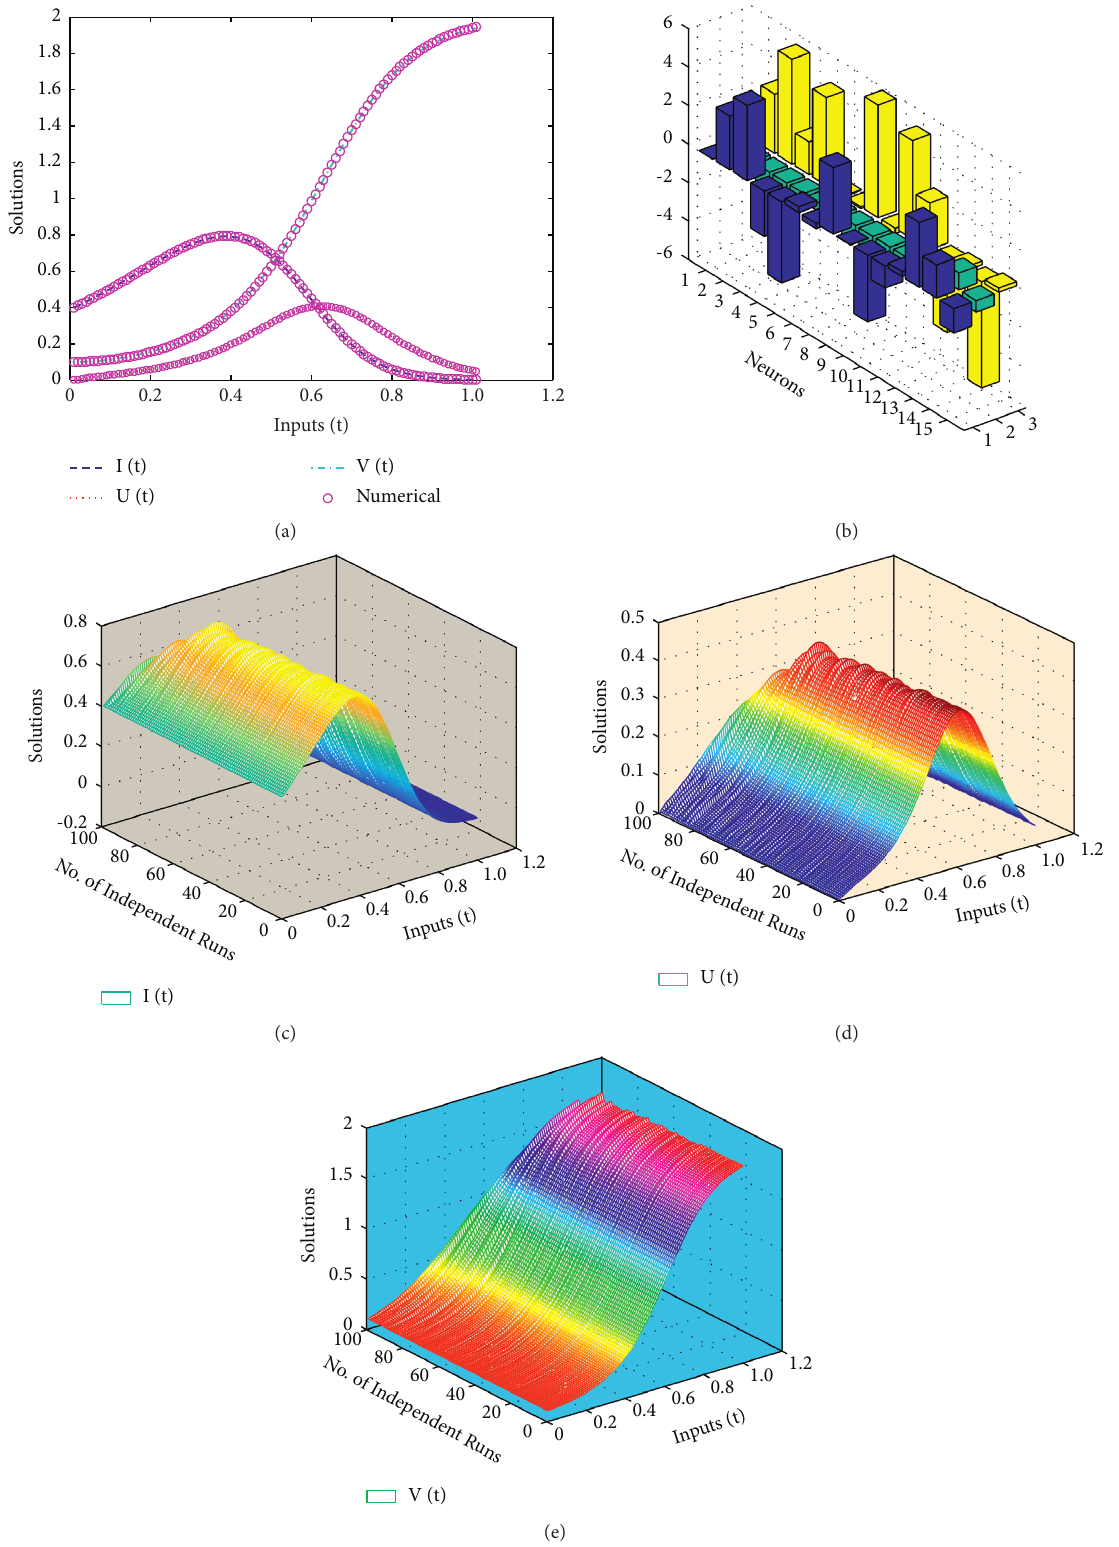
Figure 5: Problem 3: graphical evaluation for tumor growth ratio ( r ) to rate of cell lysis ( δ ) f � 0 . 36, the inverse of burst size parameter g � 0 . 02, and the viral decay ( α ) ratio to rate of cell lysis ( δ ) h � 0. (a) Solution f � 0.36, g � 0.02, and h � 0 with conditions I (0) � 0.4, U (0) � 0, and V (0) � 0.1, (b) weights obtained by ANN-SCA-SQP for CVRT, (c) solutions of 100 independent runs of I ( t ), (d) solutions of 100 independent runs of U ( t ), and (e) solutions of 100 independent runs of V ( t